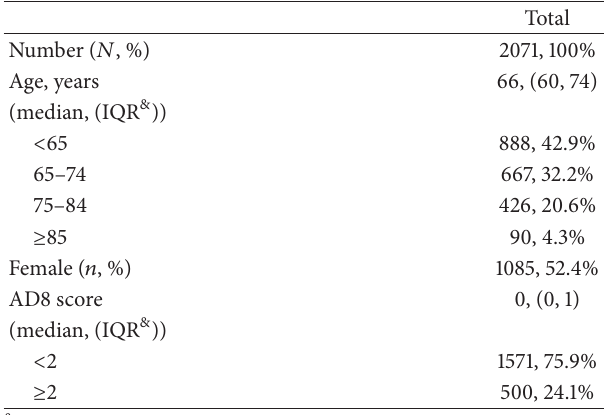
Table 1: Demographic characteristics of all the recruited partici-